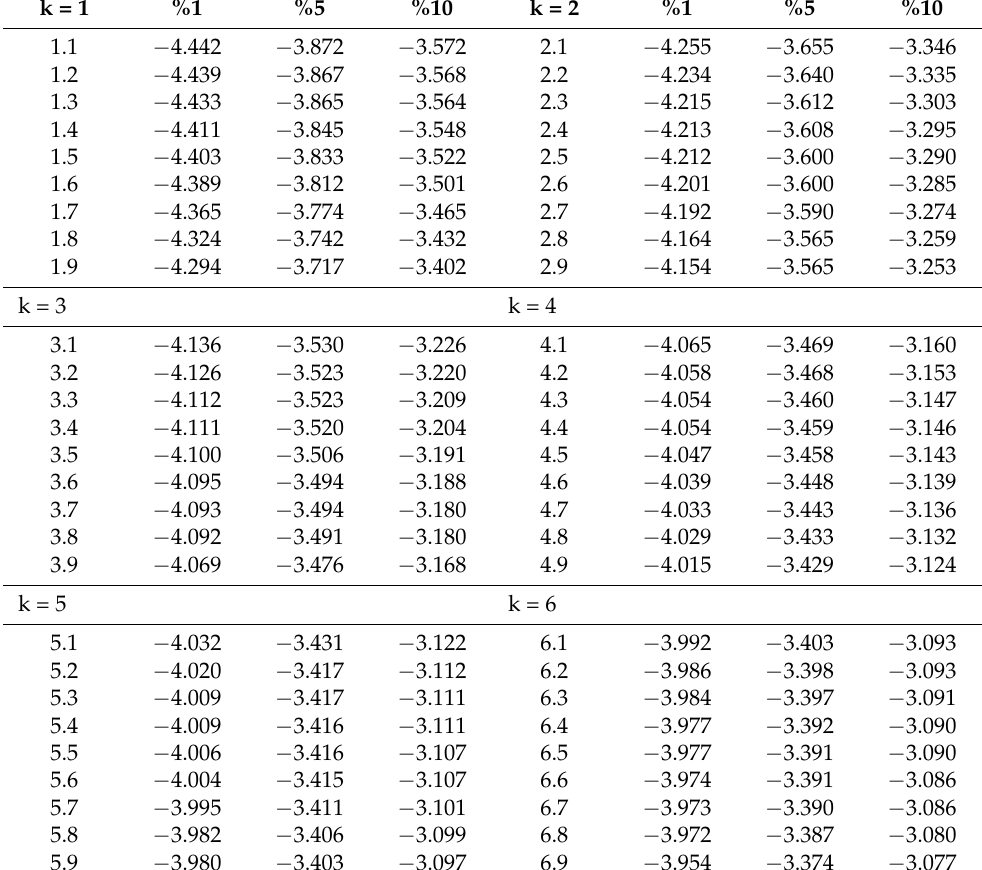
Table A2. Critical values for the one step intercept and trend